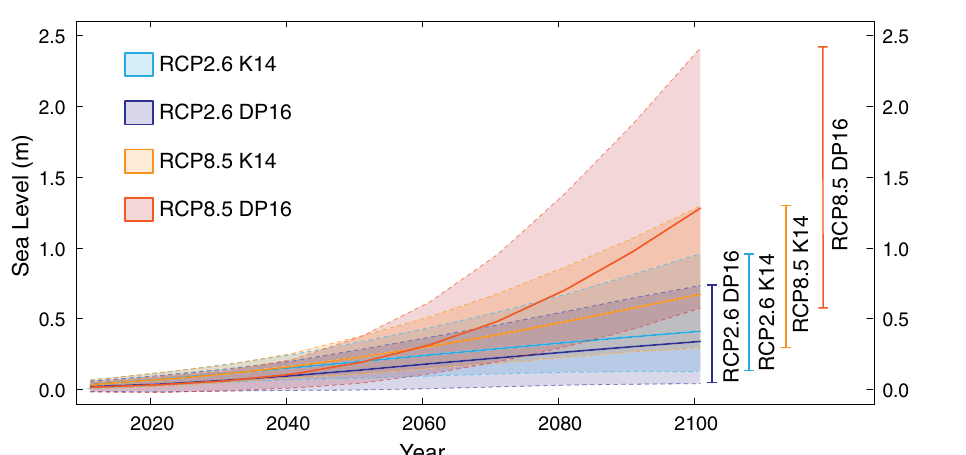
Fig. 2 Local probabilistic sea-level projections for the Ports of Los Angeles and Long Beach from 2000 to 2100. Projections are calculated using RCP2.6 (blue) and RCP8.5 (orange) projections 50 and for projections combining enhanced Antarctic Ice Sheet (AIS) contributions from 54 with the RCP2.6 (purple) and RCP8.5 (red) projections from (DP16 60 ). Solid lines in the shaded areas show the median of each projection and dashed lines bordering the shaded area and vertical lines on the right show the 95% credible